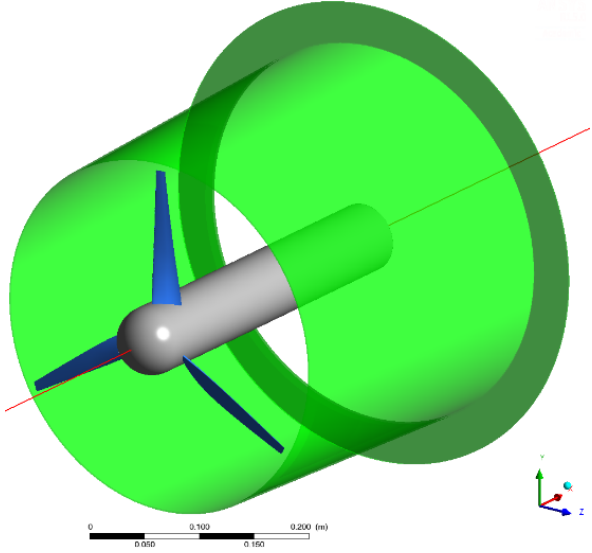
Figure 1: View of a rotor (blue) in the diffuser (green), the red line denotes the axis of rotation, the flow is from left to right (along X